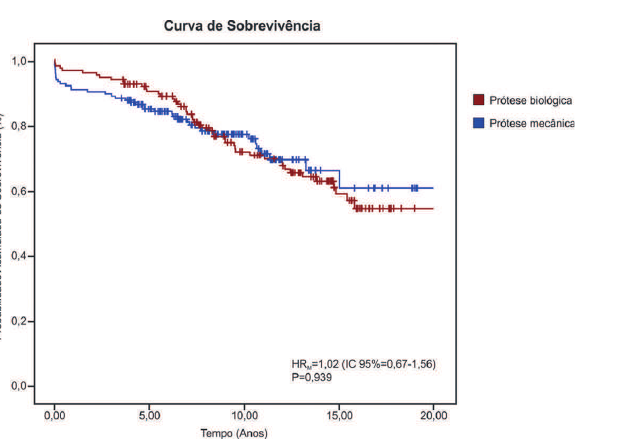
IntensivoFig. 1 - Curva de Kaplan-Meier para avaliar probabilidade de